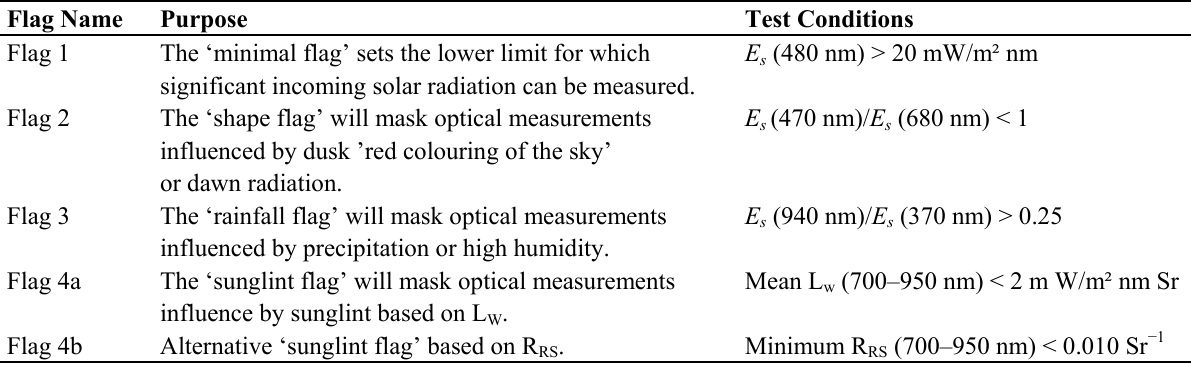
Table 2. Summarised meteorological and sunglint flag conditions. The meteorological criteria [13] are represented by Flags 1–3. The sunglint flag can be implemented either as Flag 4a or Flag 4b depending on availability of measured water leaving radiance, L remote sensing reflectance, R RS